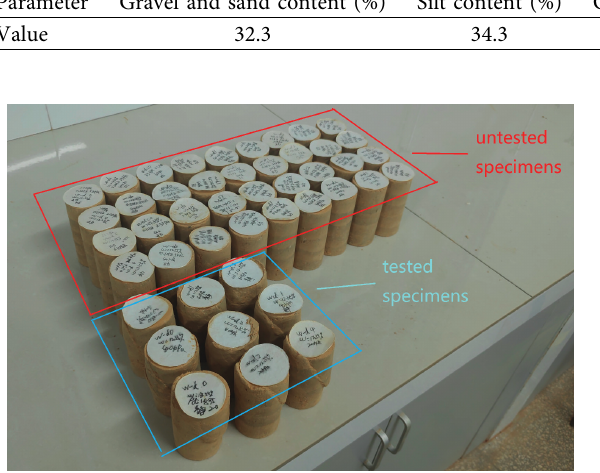
Figure 3: Cylindrical residual soil specimens.